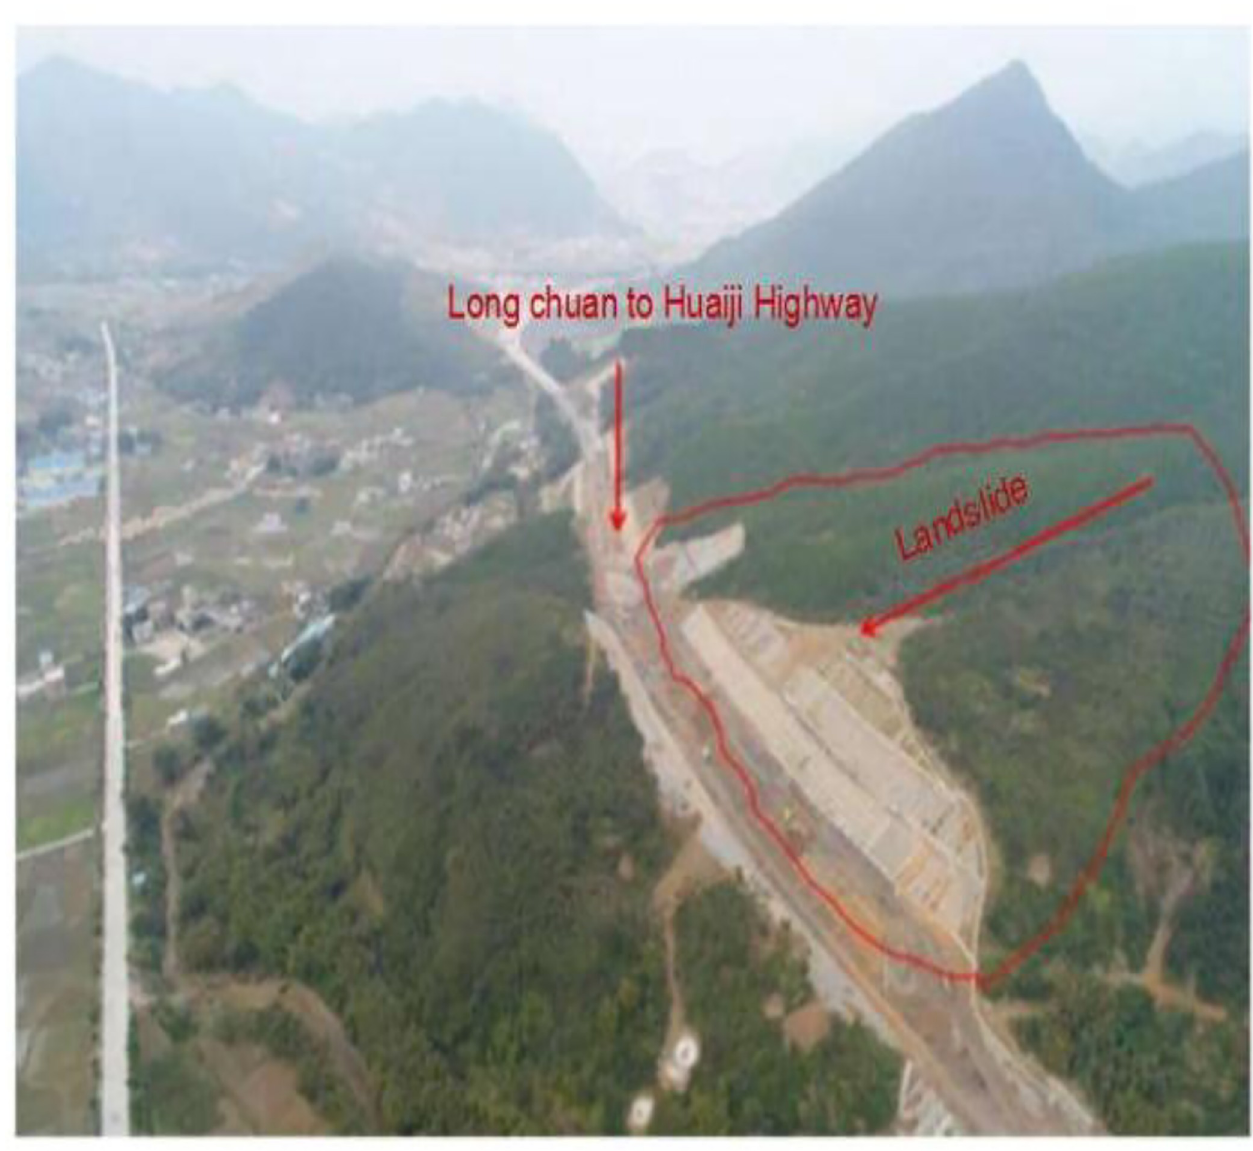
Fig 3. P lane schematic diagram of relative relationship between landslide and line.